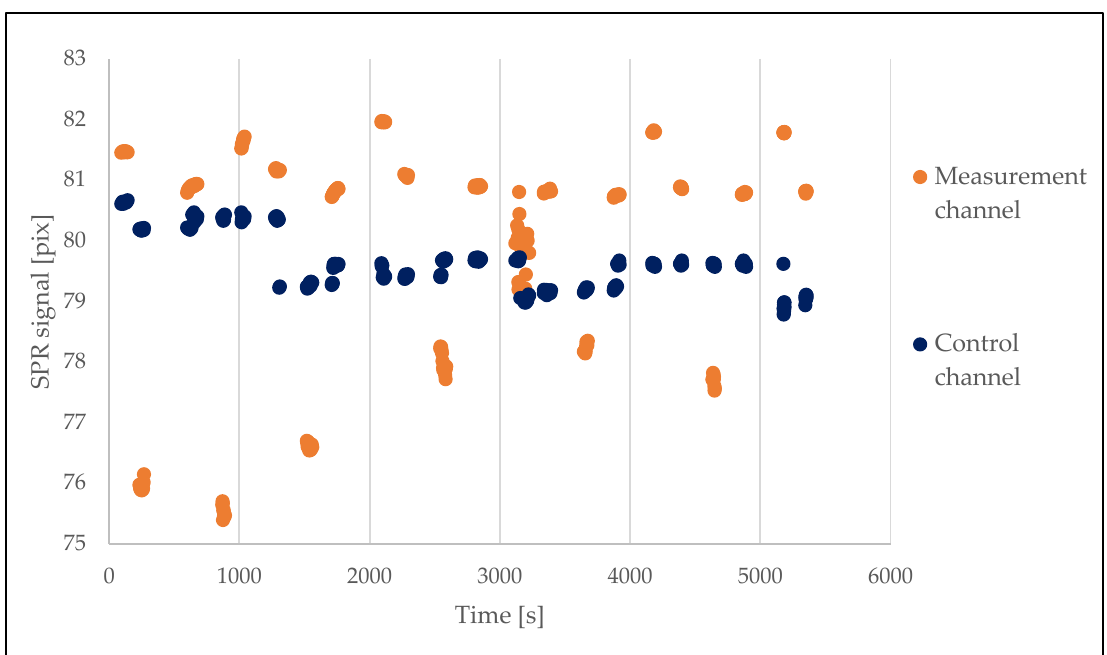
Figure 3. The SPR signal obtained during the experiment including 7 samples on a single chip. Raw data from measurement and control channels.